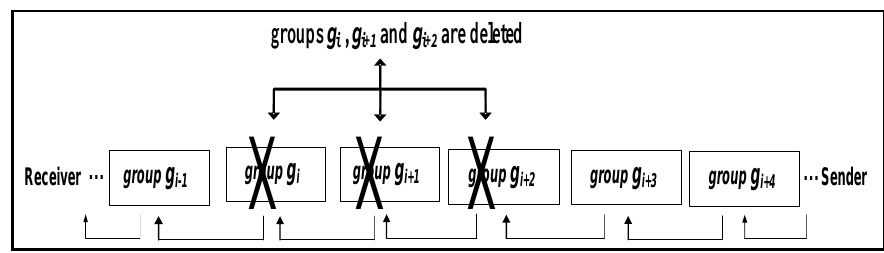
Figure 5. Group Deletion Attack.